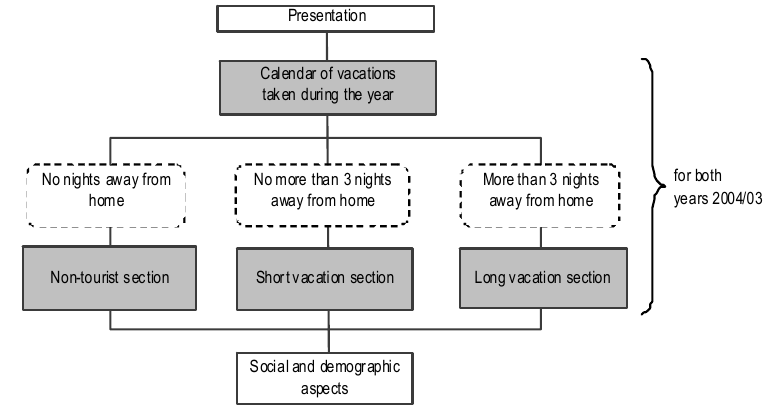
Figure 2 – Questionnaire